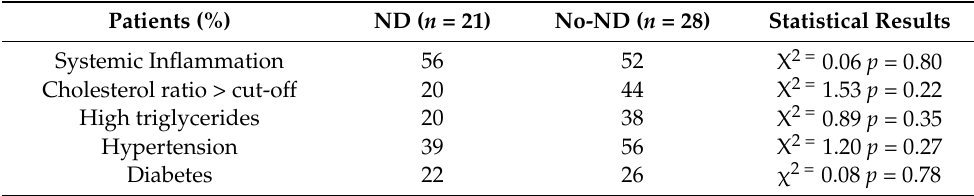
Table 3. Presence of comorbidities and statistical results in the comparison between the two groups of